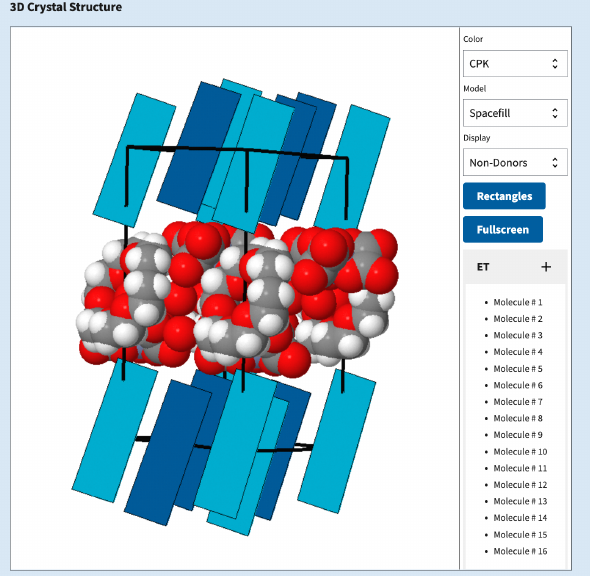
Figure 5. View of the 3D in-browser crystal structure analysis tool. The section on the right provides interactive features to the users. In this example the material is β ”-(ET) 4 [(H 3 O)Cr(C 2 O 4 ) 3 ] 2 [(H 3 O) 2 ] 5 H 2 O, as reported in